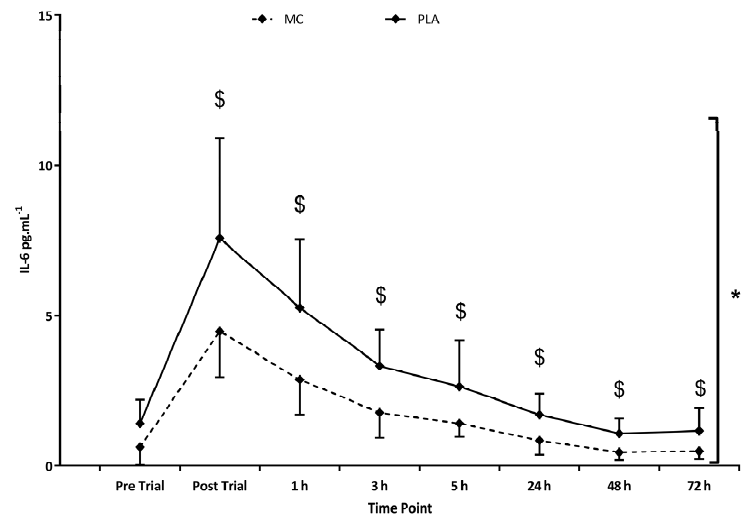
Figure 4. Interleukin ‐ 6 (IL ‐ 6) responses in the Montmorency cherry (MC) and placebo (PLA) groups the adapted Loughborough Intermittent Shuttle Test (LIST ADAPT ) exercise. * Group effect; $ Interaction effect ( p <